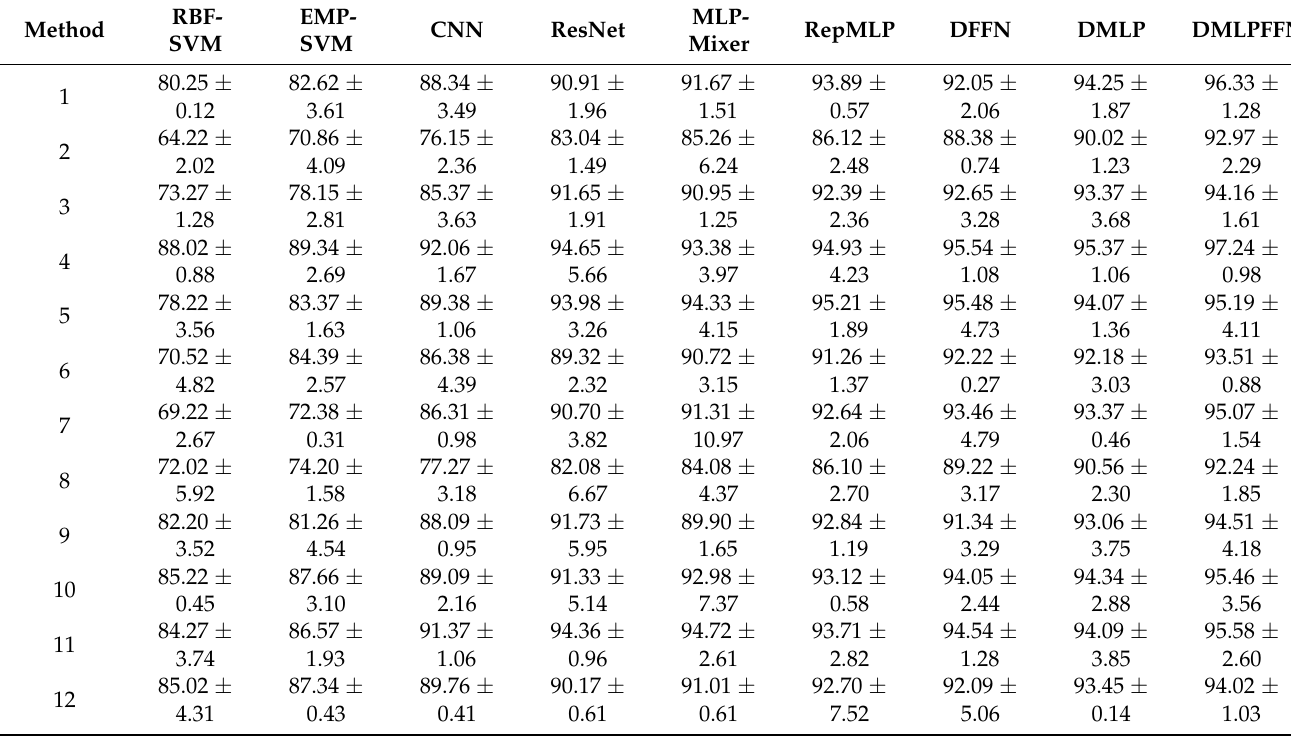
Table 9. Classification results on the HanChuan dataset by different classification